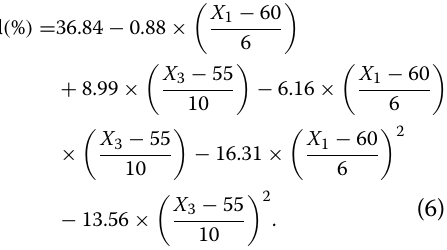
Italic values indicate significance of p value ( p < 0.05)